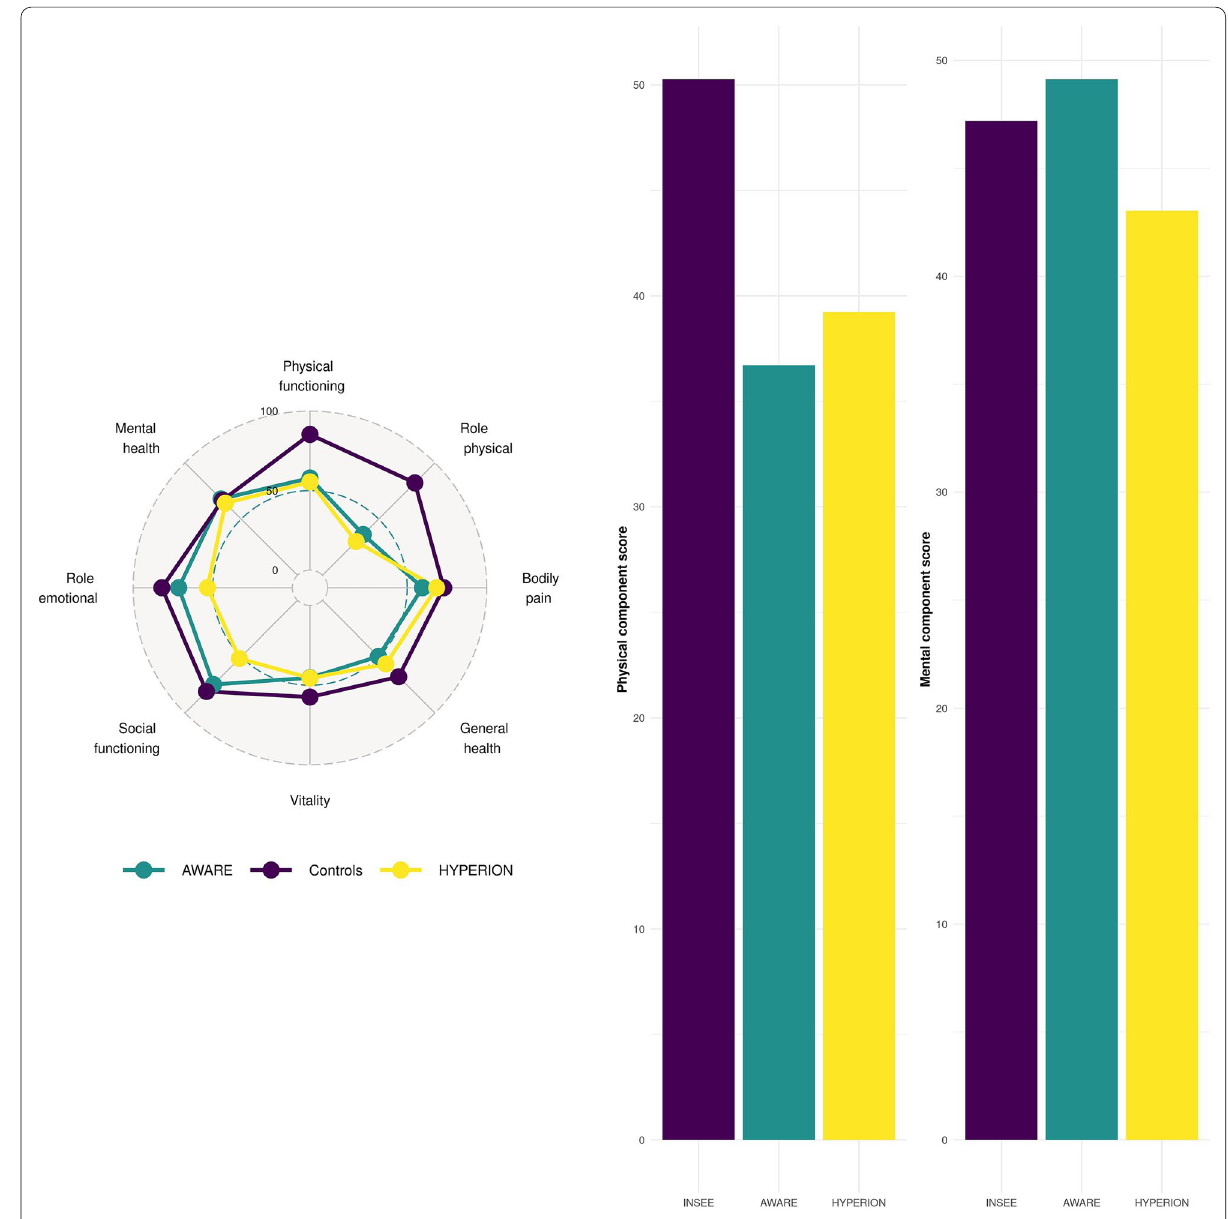
Fig. 2 Health related quality of life of patients included in the AWARE and HYPERION trials and controls from the general French population. Panel A shows the mean scores of the three groups in the 8 dimensions of the SF‑36 questionnaire. Panel B shows the mean physical and mental component scores of the three